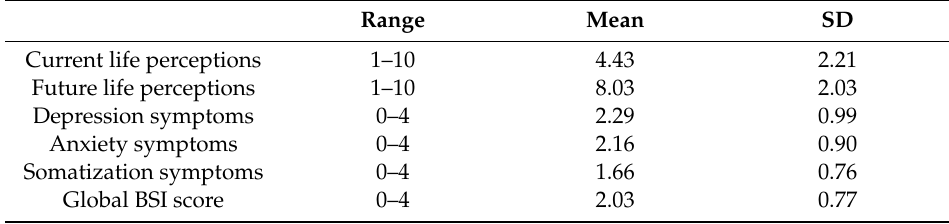
Table 1. Descriptive statistics of life perceptions and of depressive